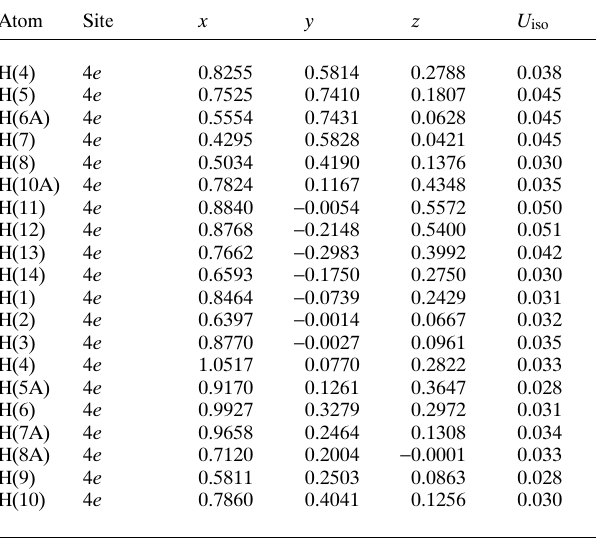
Table 2. Atomic coordinates and displacement parameters (in Å 2 )